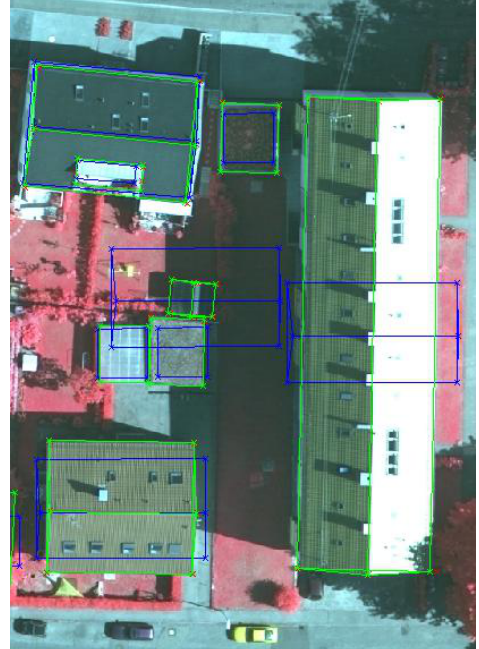
Table 1. Evaluation of geometrical accuracy in the report file